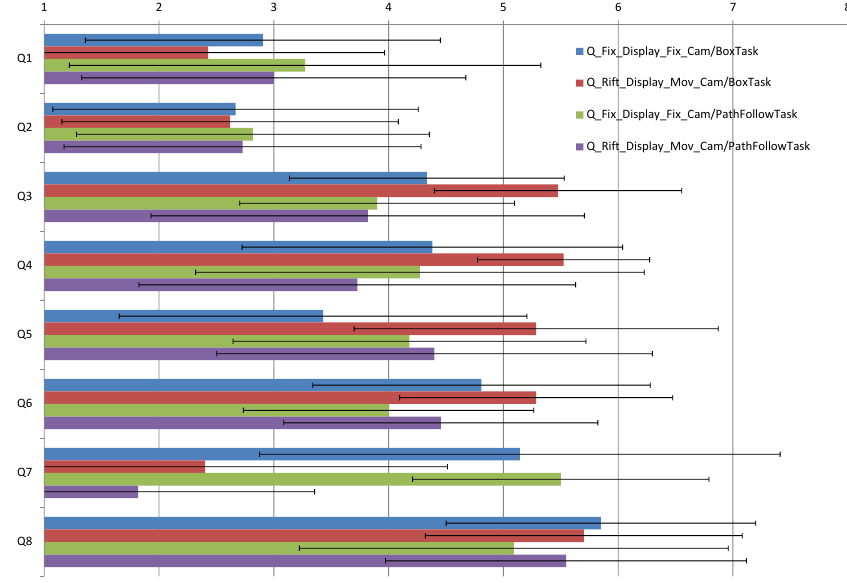
Figure 11. Comparison of mean scores from the user questionnaire feedback for the pick and place in the box task and 3D path following task, Likert scale: one to seven. Q1: I visualized the workspace (without any difficulties/with difficulties); Q2: Was the task tiring? (Not tiring/Very tiring); Q3: I managed to manipulate objects quite accurately (Not at all/Very much); Q4: The workspace visualization did not difficult object manipulation (Disagree/Agree); Q5: I forgot that I used an indirect technological visualization device (Disagree/Agree); Q6: I had a clear perception and total control of stick’s movements? (Not at all/Yes totally); Q7: I perform better when: (I move my